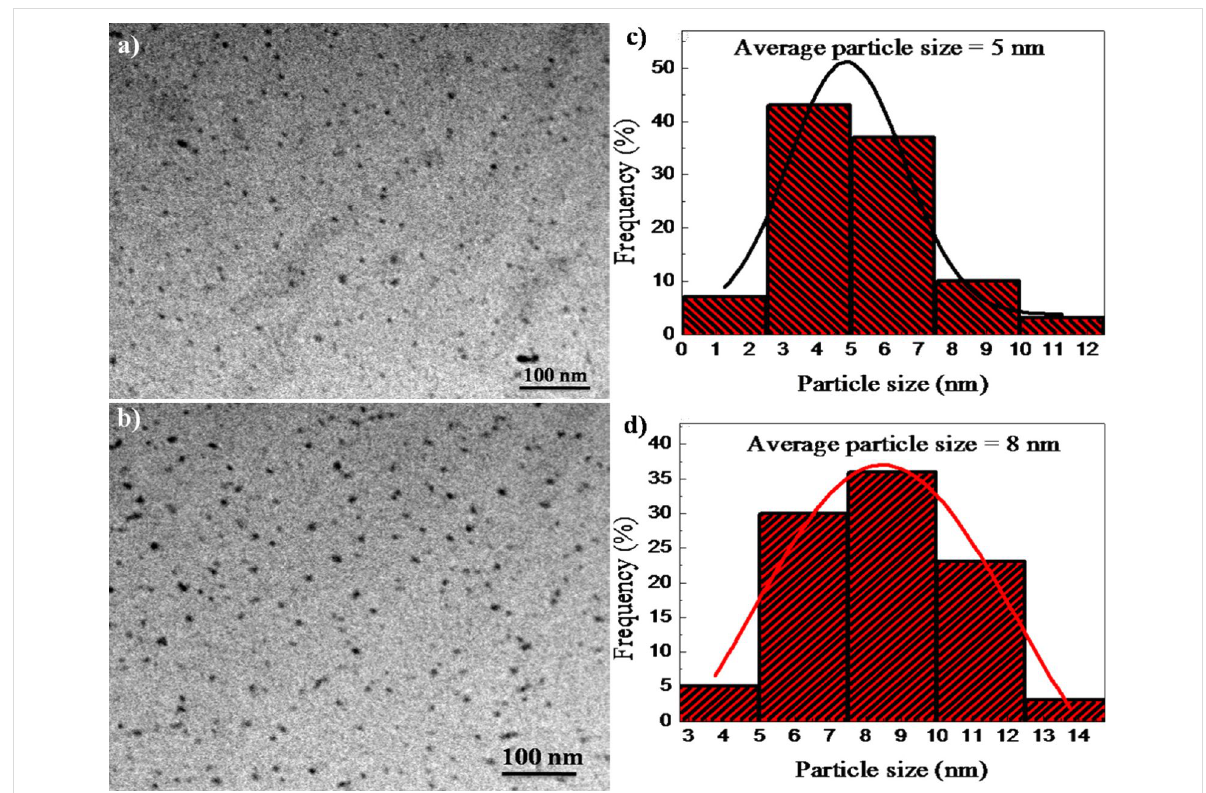
Figure 5: TEM micrographs of sputtered particles of (a) 2 atomic % Zn in silica and (b) 10 atomic % Zn in silica. (c) Size distribution of the particles corresponding to Figure 5a. (d) Size distribution corresponding to Figure 5b.